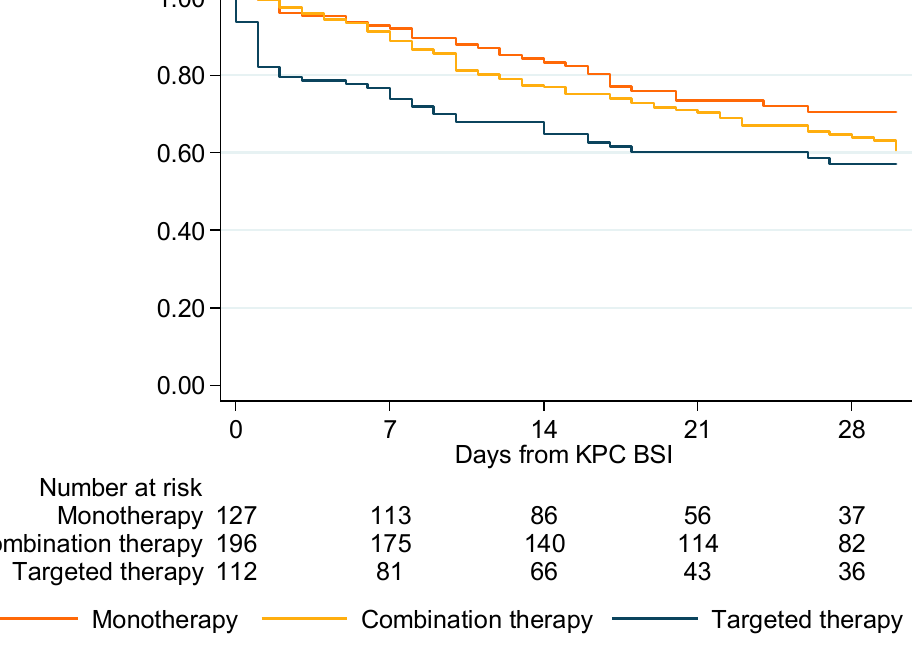
Figure 2. Kaplan–Meier estimate of survival for patients administered empirical monotherapy, empirical combination therapy and targeted therapy ( n = 435).